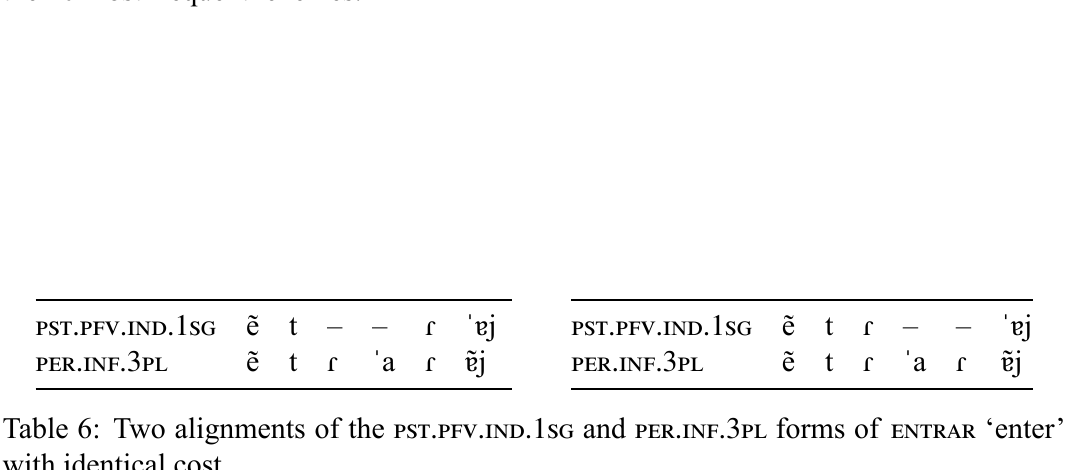
Table 5: Inferring patterns in three steps for the cells the PRS.IND.1SG and PRS.SBJV.1SG of the 20 most frequent lexemes.